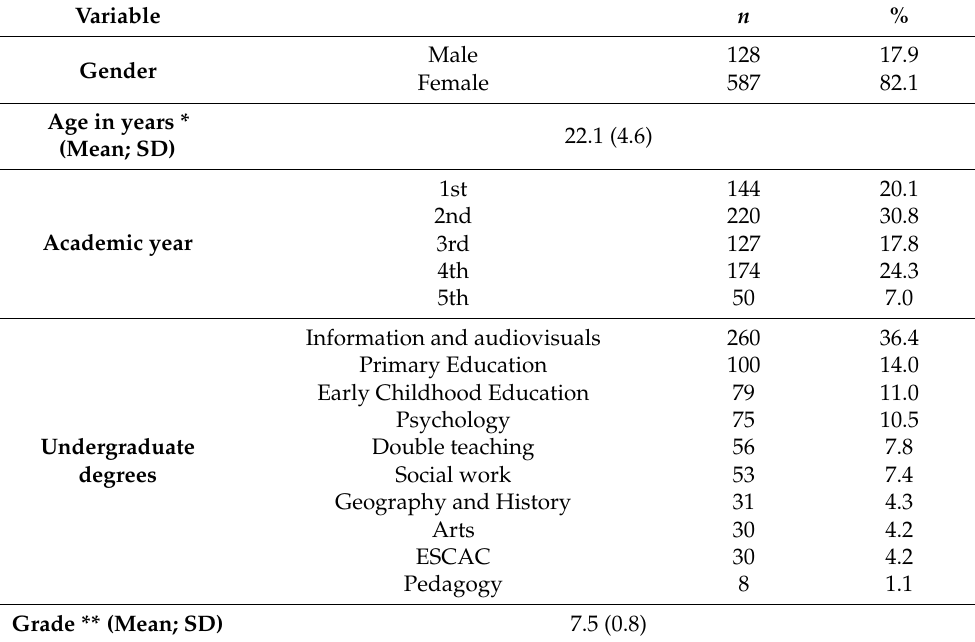
Table 1. Description of the sample ( n =